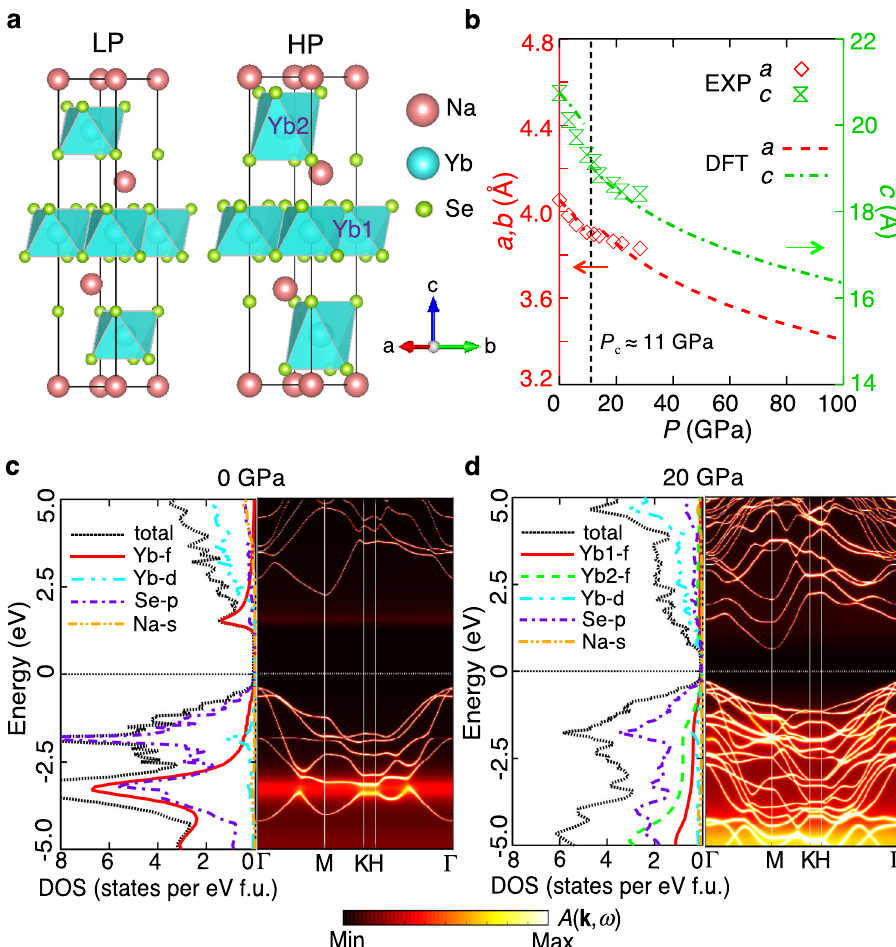
Fig. 1 Lattice structure and low-pressure electronic structures of NaYbSe 2 . a Comparison of the crystal structures at low (LP) and high pressures (HP). b Optimized lattice parameters as a function of pressure compared with experiment 19,20 . c , d Orbital-resolved density of states and the spectral function at ambient pressure and 20 GPa obtained by DFT + DMFT at 10